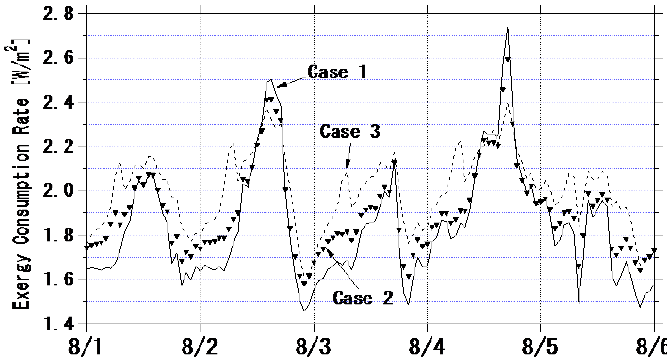
Figure 6. Human body exergy consumption rate.